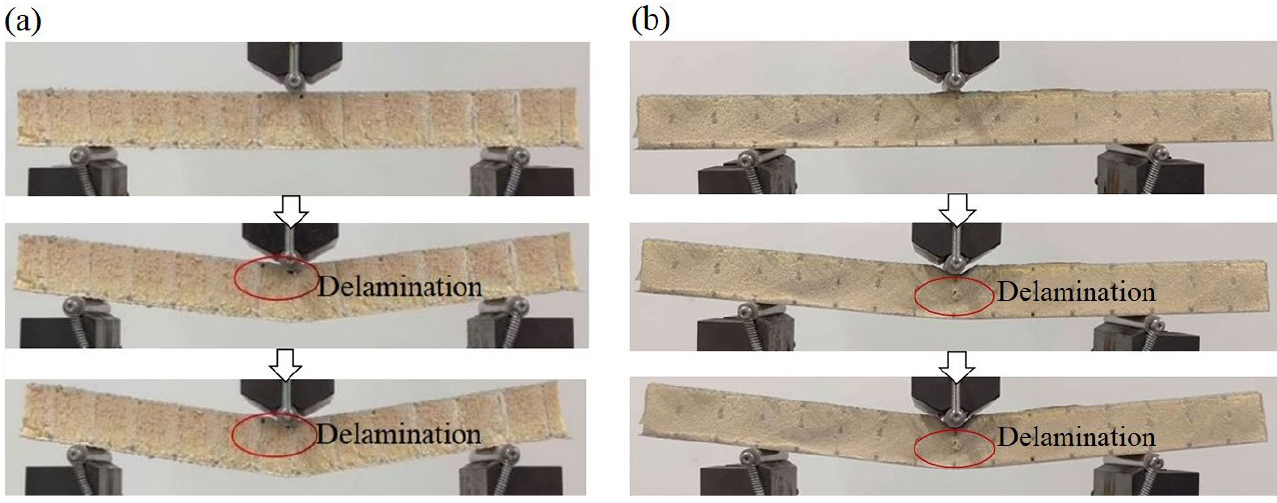
Figure 25. Side images of the crack failure process of samples 3 ( a ) and sample 3 ( b ) of the two types of slotted-hole foam-core sandwich composites by bending test.